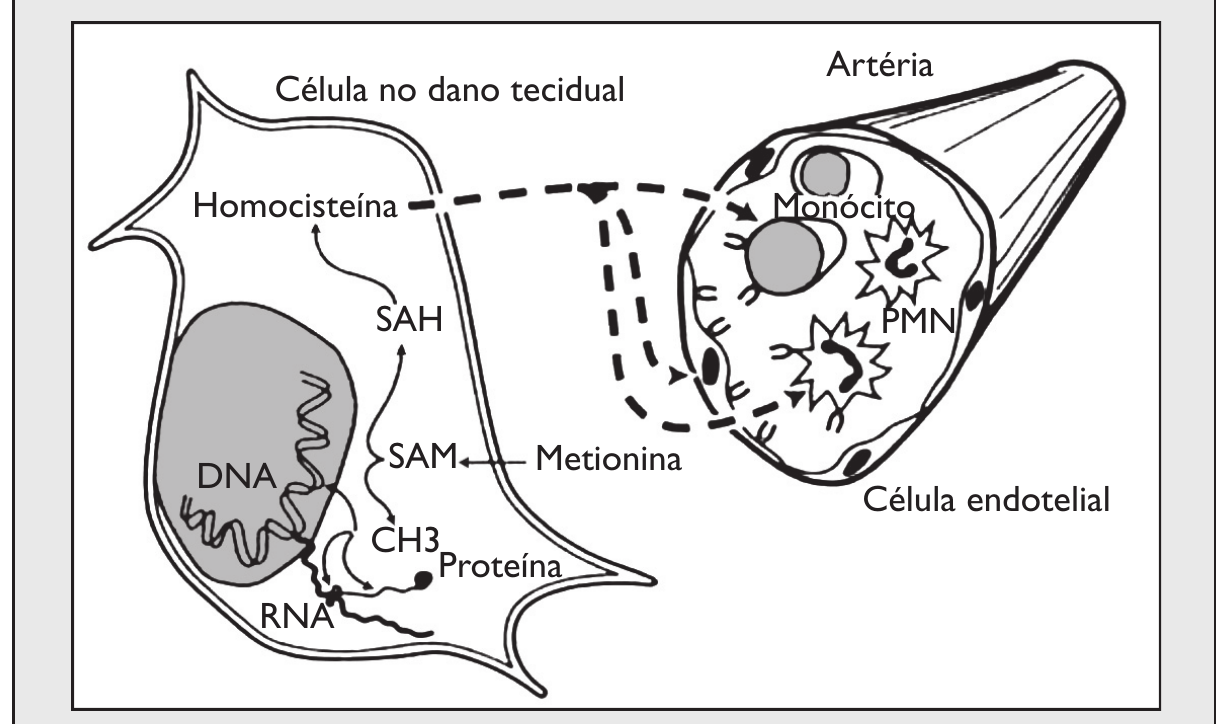
Figura 3 – Hipótese para associação entre homocisteína e doença vascular (17) PMN =